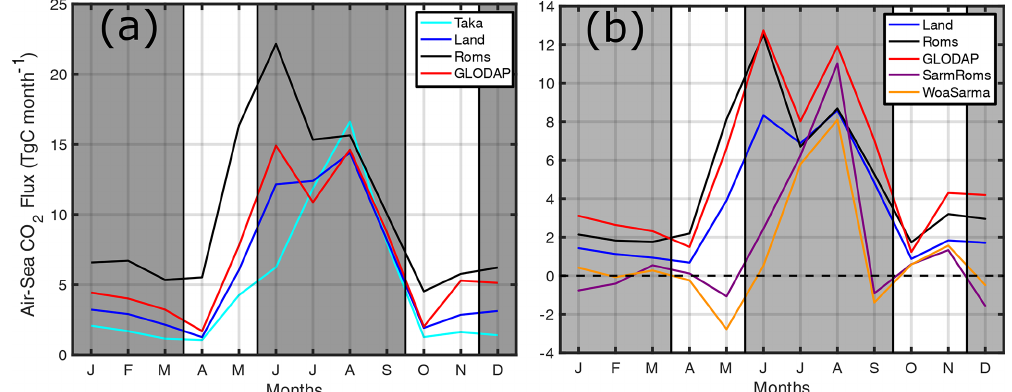
Figure 9. (a) Monthly CO 2 flux (TgCmonth − 1 ) from the AS as calculated using p CO 2 from TK09 (cyan), L15 (blue), model (black), and GLODAP (red). (b) Monthly CO 2 flux from 10 ◦ N and north using p CO 2 from L15 (blue), model (black), GLODAP (red), Sarma using model output (purple), and Sarma using WOA data (orange). Dashed line in (b) is the zero flux axis, and gray regions denote winter and summer monsoons. Positive flux is out from the ocean